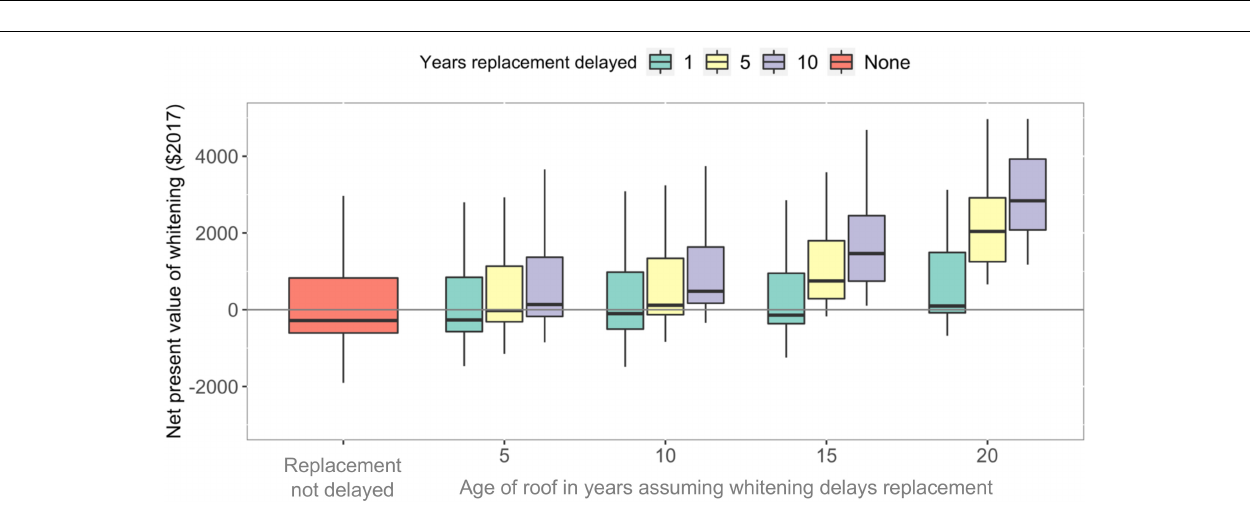
FIGURE 3 | Household net present values for heating penalty, cooling savings, whitening savings, and savings from delaying roof replacement as a result of coating. The ranges include all sources of variability and uncertainty summarized in Table 2 and reflect the first and third quartiles. Results are shown for a discount rate of 5%. Similar results for discount rates of 3% and 7% are included in the Supplementary Information .